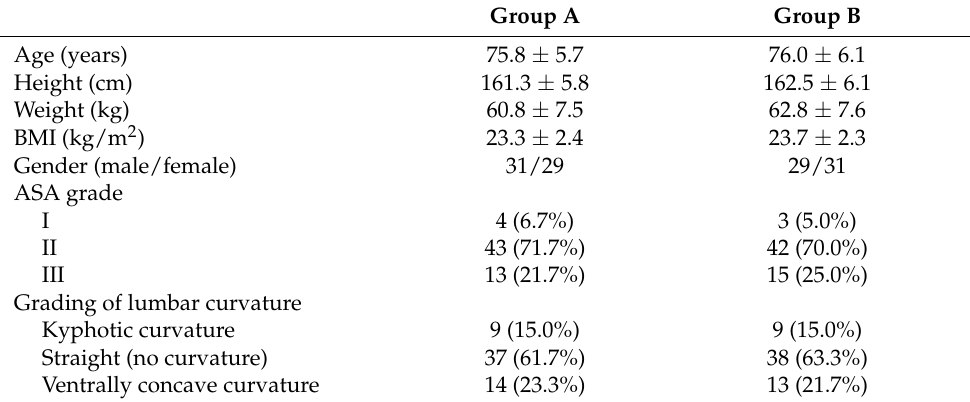
Table 1. Demographic and clinical characteristics.